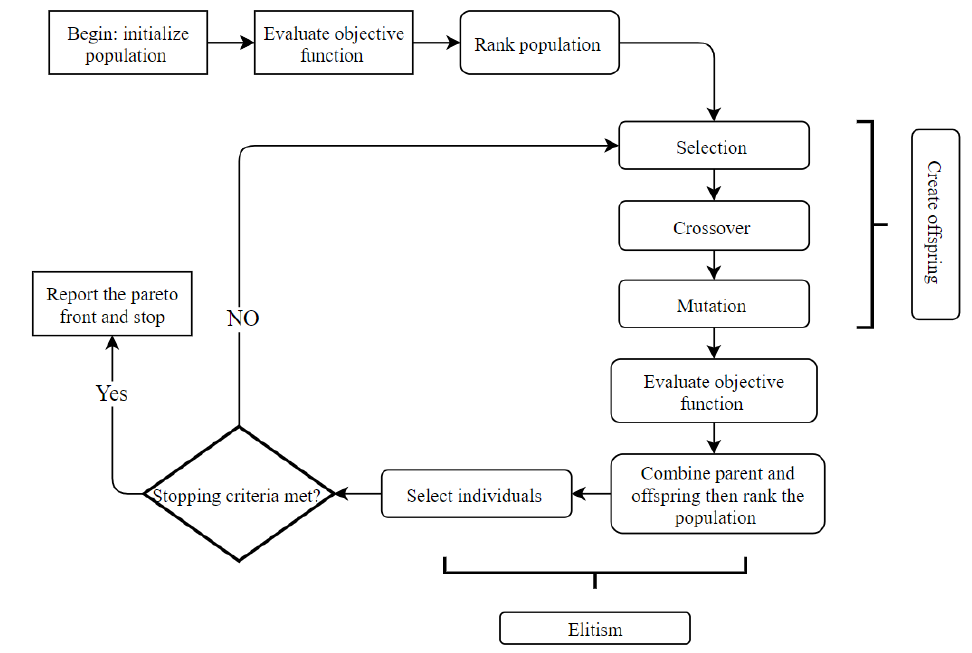
Figure 4. General flowchart of NSGA-II.